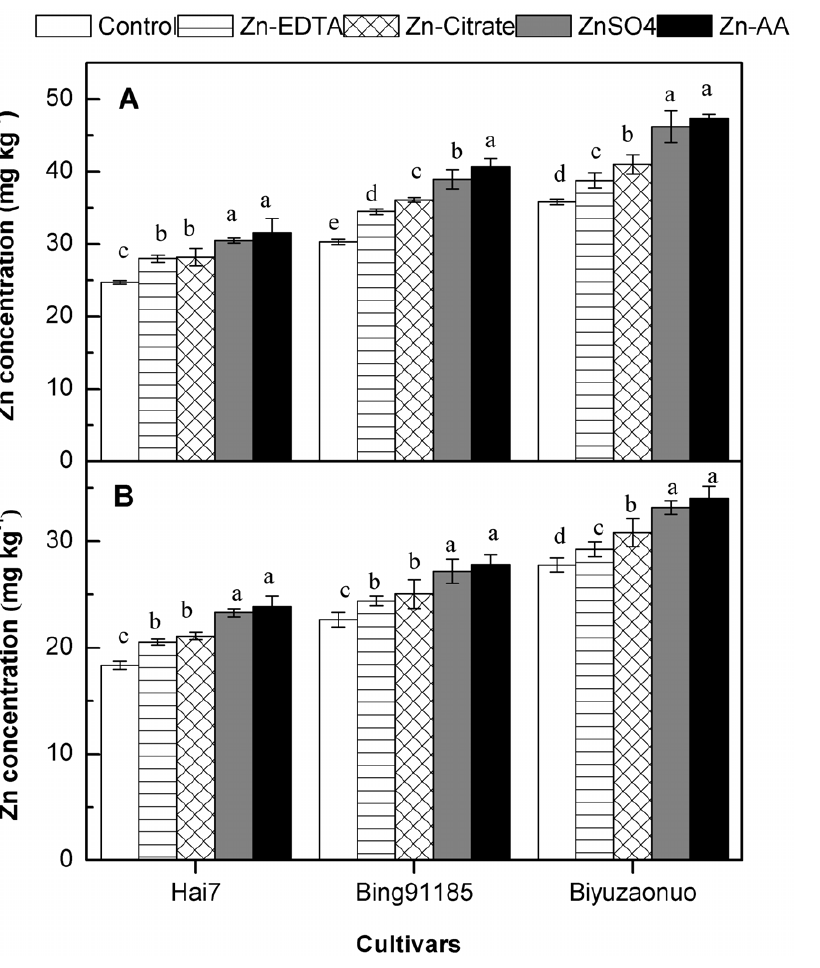
Figure 2. Zn concentration in rice grain among three cultivars. (A) Zn concentration in brown rice. (B) Zn concentration in polished rice. Error bars indicate standard errors of the means (n=4). Different letters indicate significant difference among Zn treatments according to LSD test (P , 0.05).